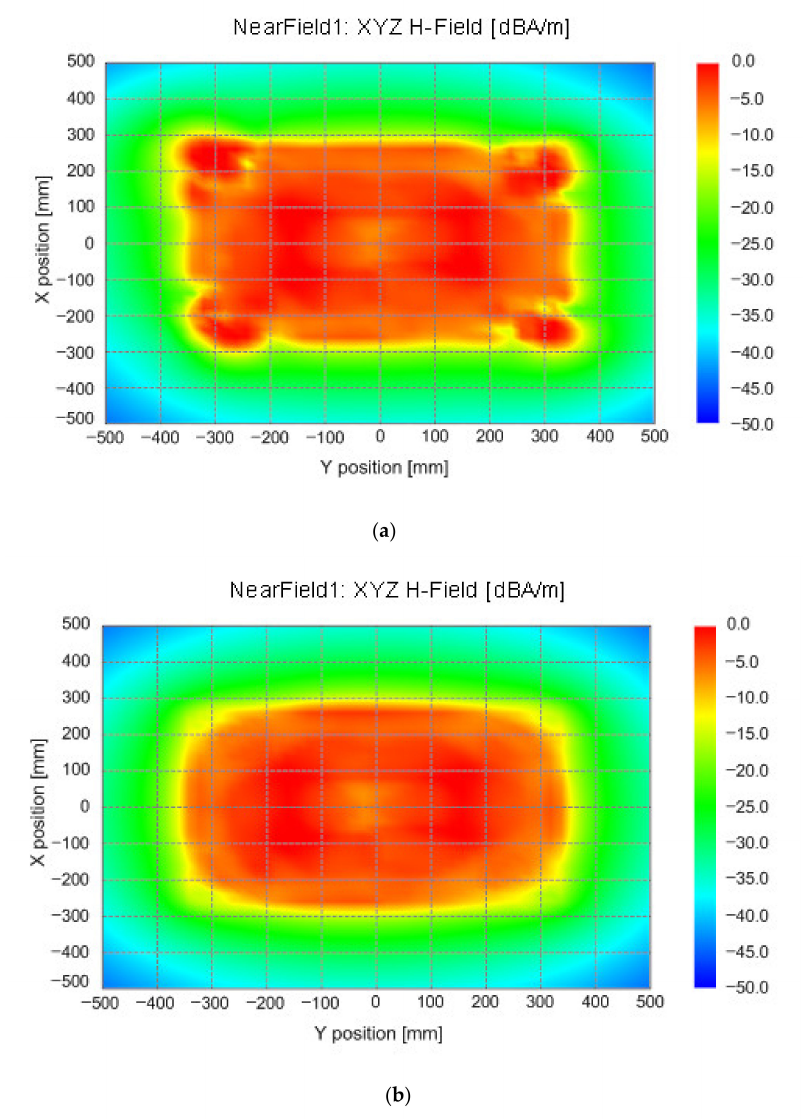
Figure 7. Simulation results when the ferrite antenna is mounted on each corner of the WPT system for EV. ( a ) Keyless entry system; ( b ) smart key